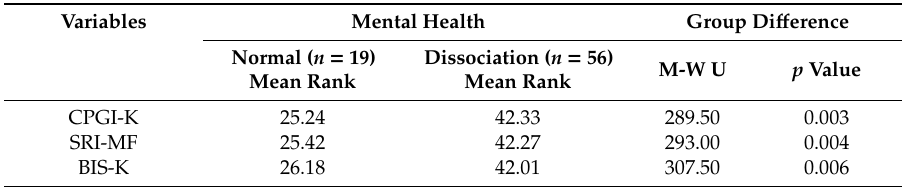
Table 6. Comparison of mental health problems in PIS participants with and without